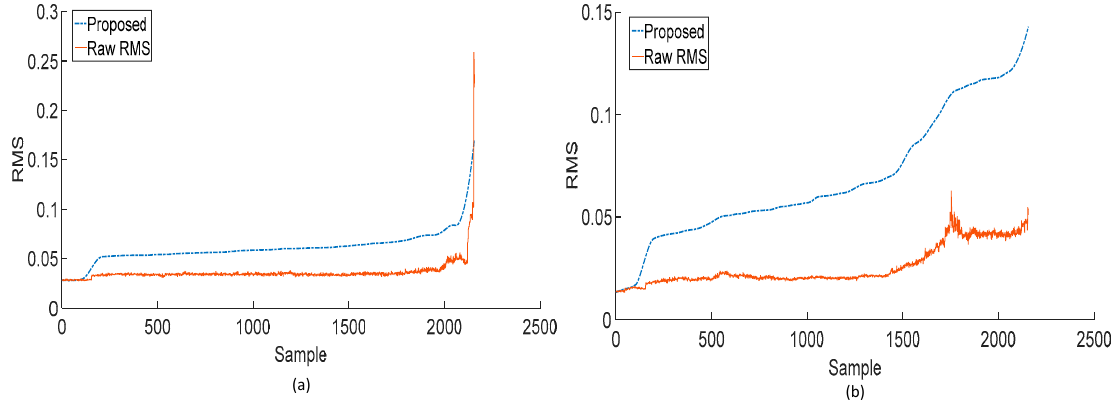
Figure 5. Comparison of RMS trends extracted directly from the raw vibration signals and RMS trends extracted using the proposed method for ( a ) bearing 3 and ( b ) bearing 4 of the first run-to-failure test of the IMS dataset.